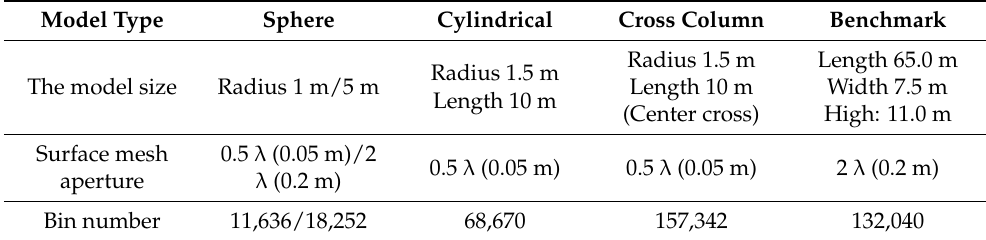
Table 1. Description of calculation